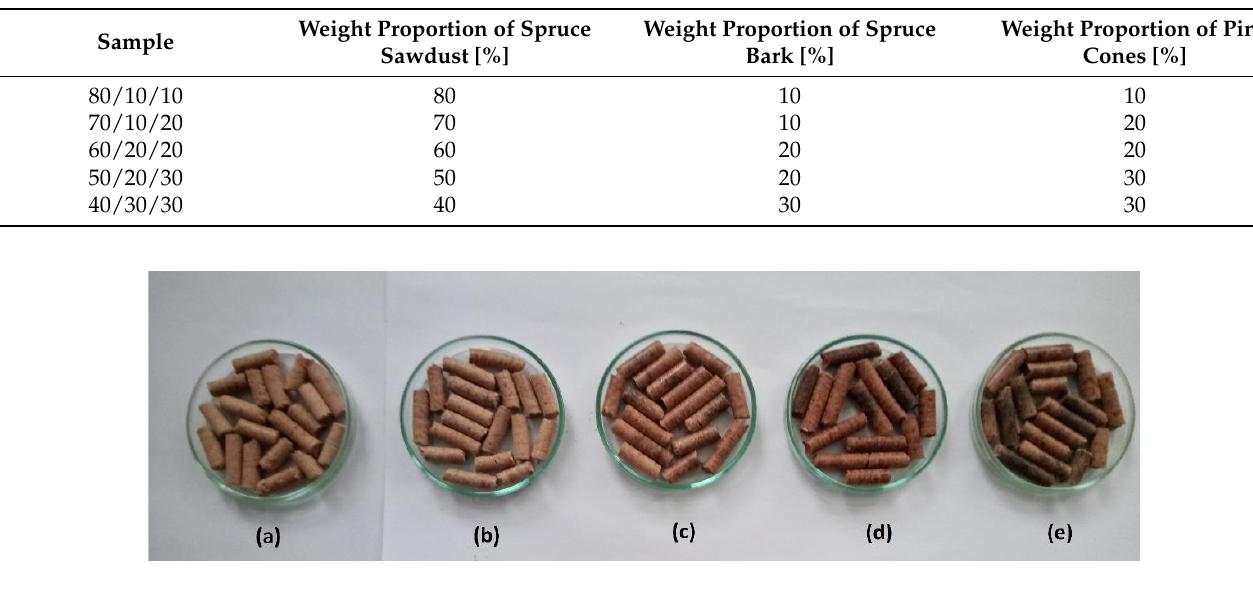
4 of 9 Figure 1. The input materials: ( a ) spruce sawdust; ( b ) spruce bark; ( c ) pine cones.